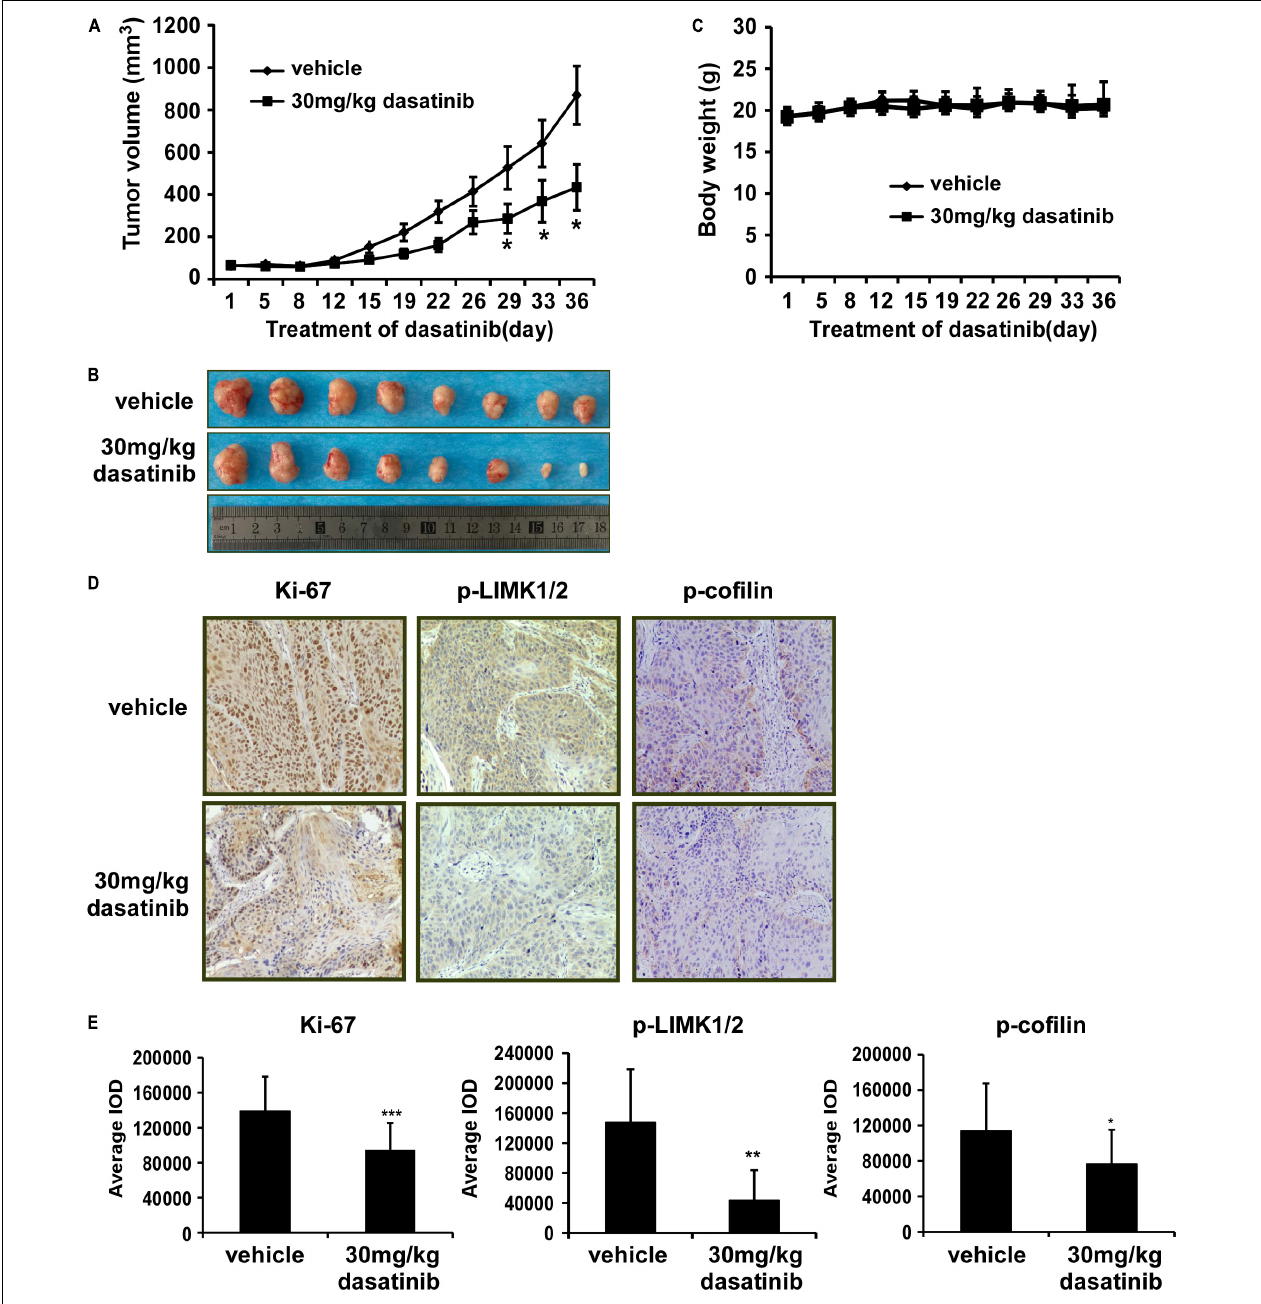
FIGURE 6 | Dasatinib attenuates the growth of PDX tumors in mice. (A) The effect of dasatinib on the volume of PDX tumors is plotted over 36 days. Vehicle or 30 mg/kg dasatinib is administered by gavage. Tumor volume is measured twice a week. The asterisk (* p < 0.05) indicates a significant decrease in volume of tumors from dasatinib-treated mice in comparison with vehicle-treated mice. Data are shown as mean ± SD values. (B) The photographs of tumors from PDX mice treated with vehicle or 30 mg/kg dasatinib. (C) Body weight of mice is plotted over 36 days. (D) The expression of Ki-67, p-LIMK, and p-cofilin is examined by IHC analysis (100X magnification). (E) The expression of Ki-67, p-LIMK and p-cofilin are quantified from 4 separate areas on each slide. Data are expressed as IOD values ± SD . The asterisks (* p < 0.05, ** p < 0.01, *** p < 0.001) indicate a significant decrease in Ki-67, p-LIMK, and p-cofilin in dasatinib treated tissues compared to vehicle treated